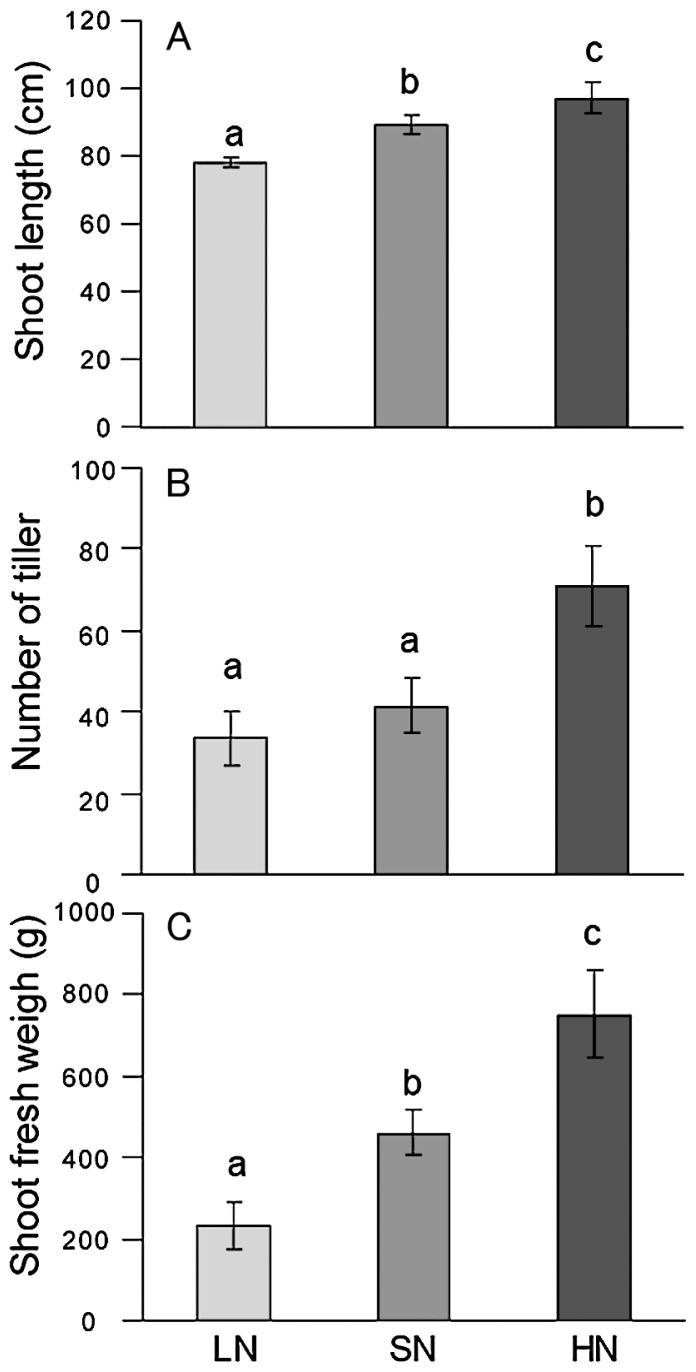
Growth parameters of rice grown under low (LN), standard (SN), and high (HN) N fertilization regimes. (A) Shoot length, (B) number of tillers, and (C) fresh weight of shoots. Data show the mean ± SEM. Whole plants were destructively sampled at the booting stage on 27 August 2009 and weighed. Bars bearing the same letter (a–c) within a panel are not significantly different according to Tukey’s test for pairwise mean comparison at α = 0.05.